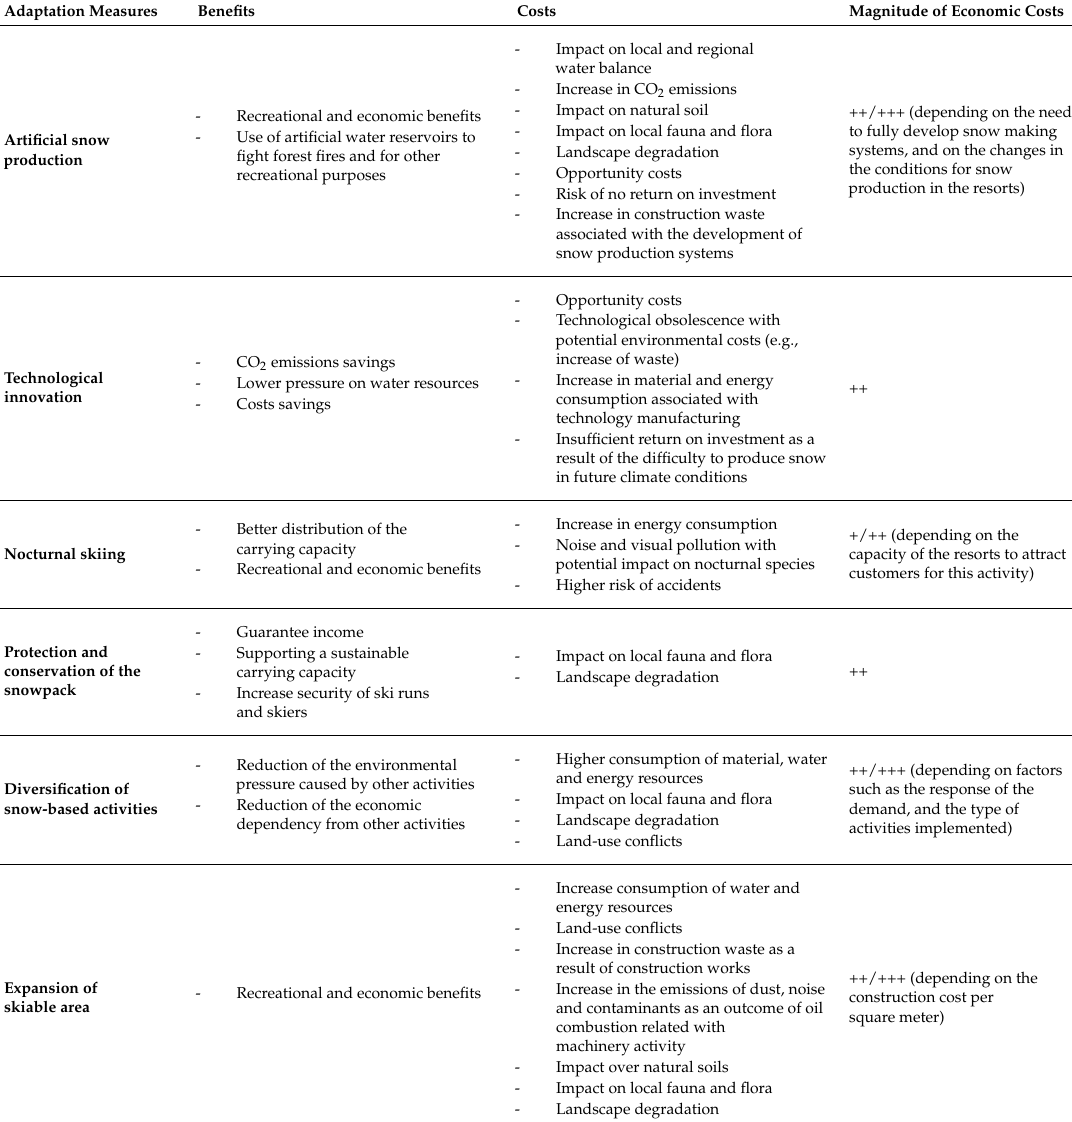
Table 5. Socio-economic and environmental costs and benefits associated with adaptation